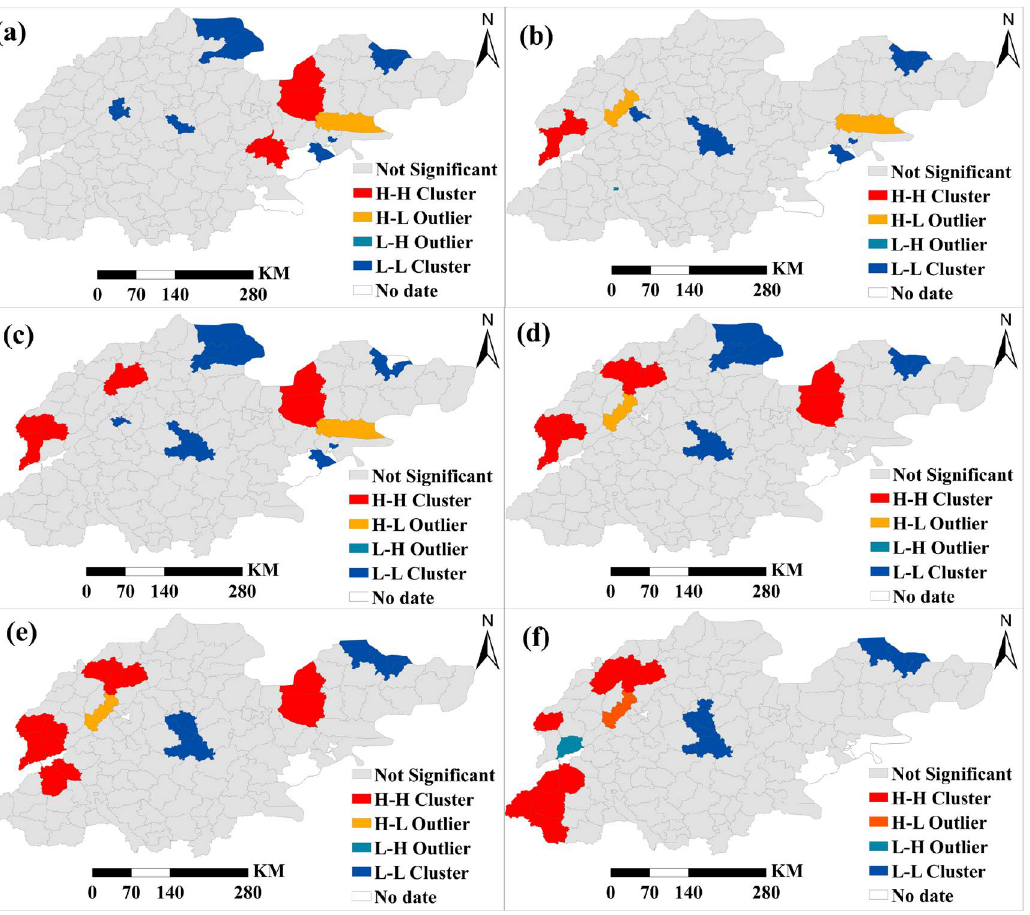
Figure 2. Lisa map of the spatial pattern of grain production in 1995 ( a ), 2000 ( b ), 2005 ( c ), 2010 ( d ), 2015 ( e ), and 2020 ( f ).